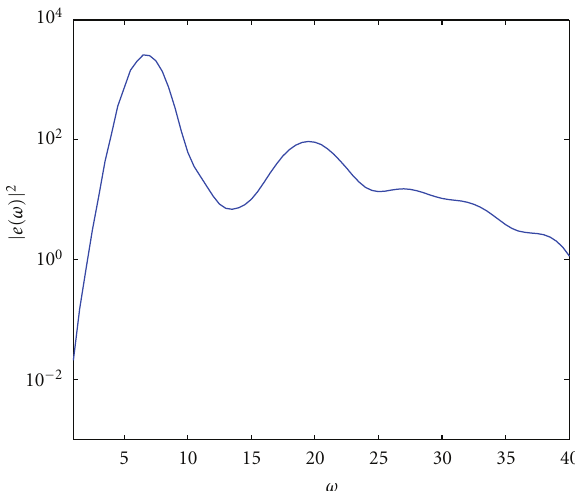
Figure 2: Spectral content of a pulse at early stages of evolution, showing generation of third harmonics ( B = 0 . 0001). e ( ω ) is the Fourier transform of the centerline profile E 0 ( r = 0).